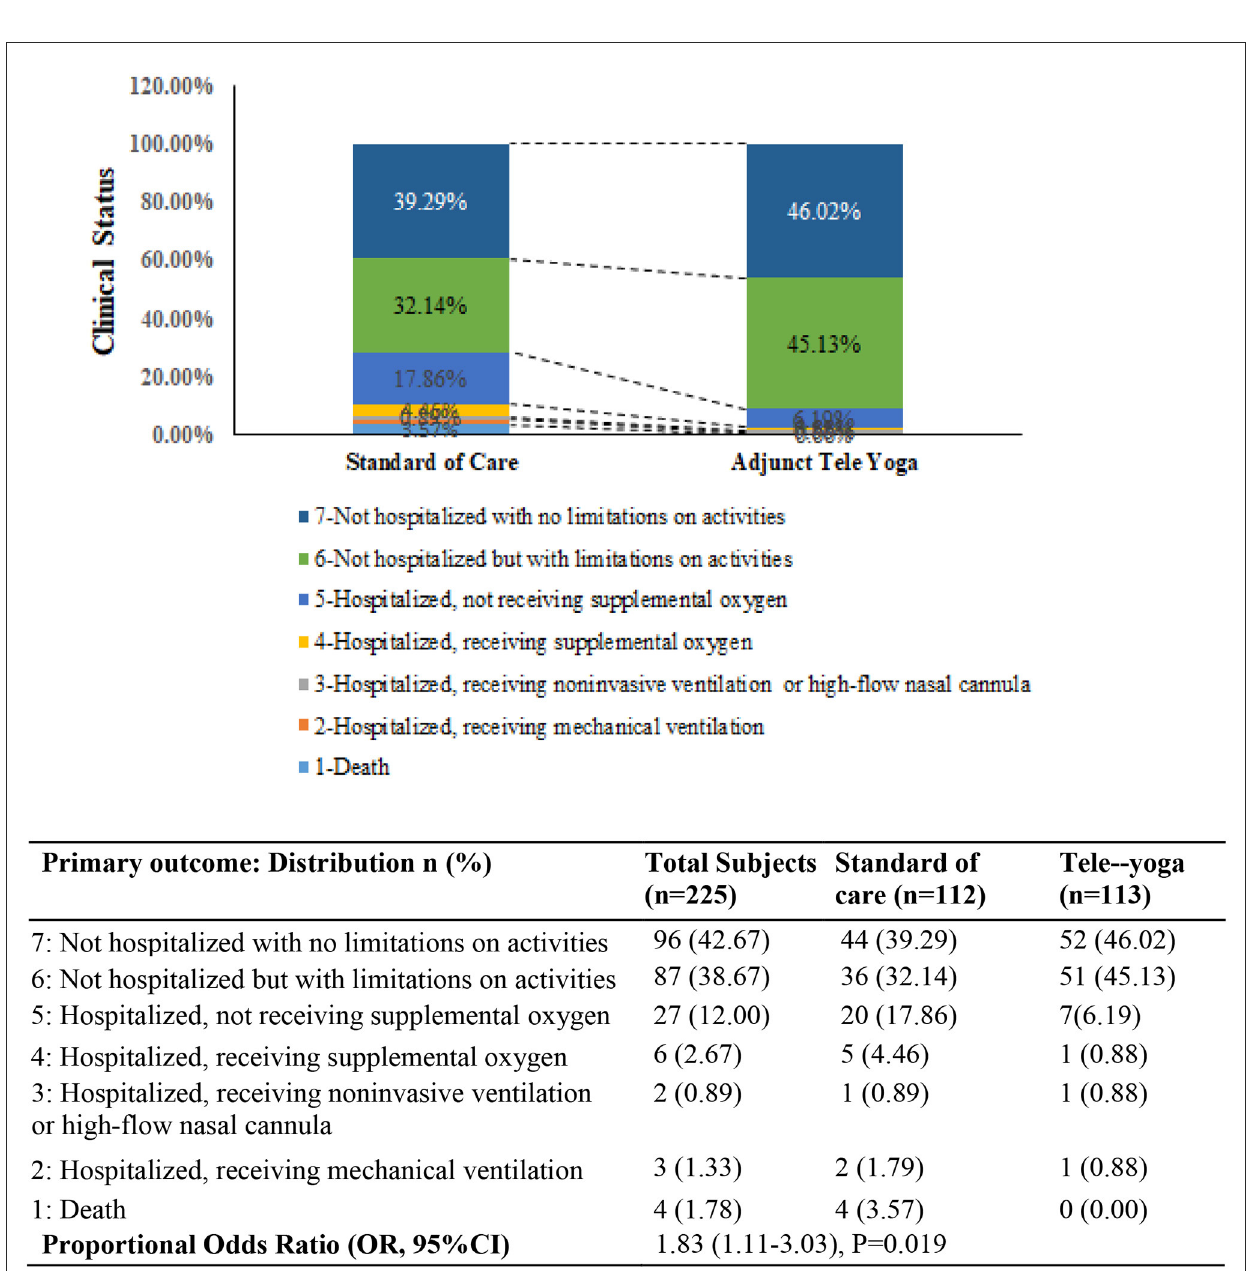
FIGURE2 Clinical status on the coronavirus disease (COVID) outcomes scale 14 days. The primary outcome was assessed in all patients who were still in the hospital on day 14 exactly and in outpatients (by means of telephonic interview) as close to day 14 as possible. OR—odds ratio was derived from the multivariable proportional odds model adjusted for baseline age, sex, and comorbidities (diabetes, hypertension, and hypothyroid). P -value < 0.05 was considered significant.